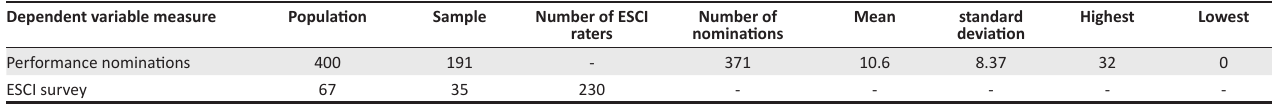
FIGURE 1: The study’s empirical framework: The relationship between emotional and social intelligence (EI) competencies and leadership TABLE 1: Descriptive statistics of the Emotional and Social Competence Inventory survey and performance nomination scores. Dependent variable measure